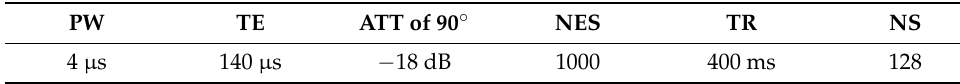
Figure 8. The pulse sequence of CPMG.